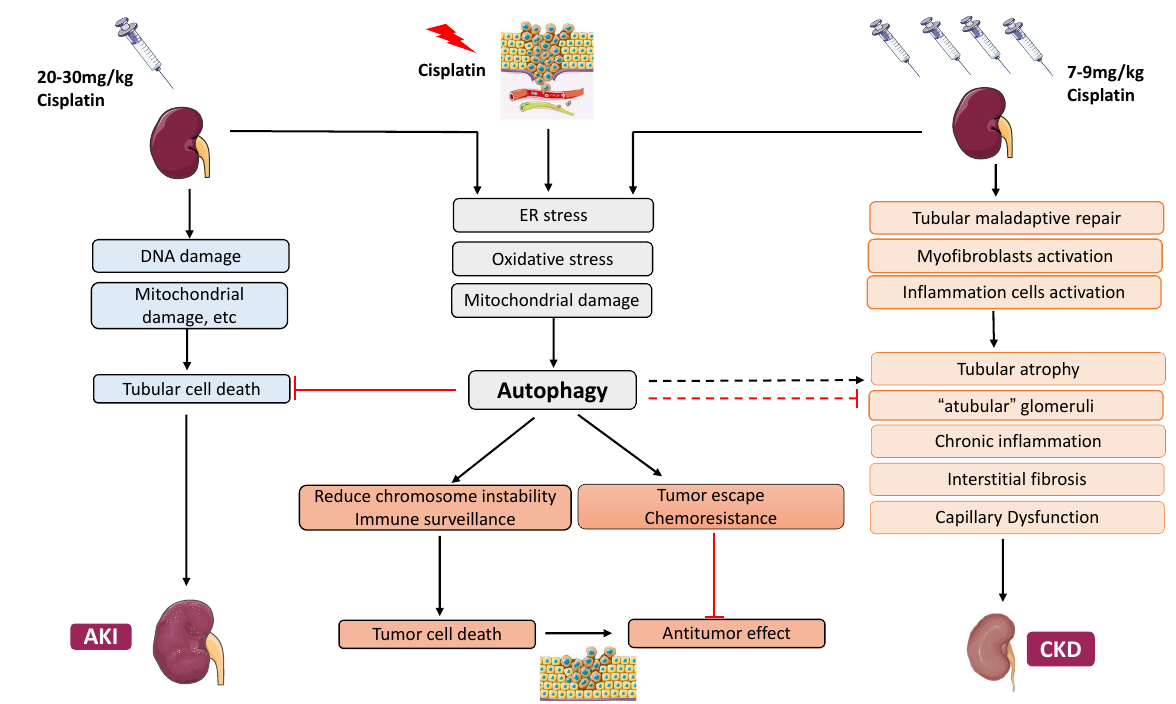
Figure 3. Autophagy in cisplatin-induced nephrotoxicity during cancer therapy. In kidneys, autophagy protects tubular cells against acute kidney injury induced by cisplatin. Autophagy may also affect the development of CKD through its regulation of tubular atrophy, interstitial fibrosis, etc. In cancers, autophagy may suppress tumorigenesis, but it increases the resistance of cancer cells to cisplatin